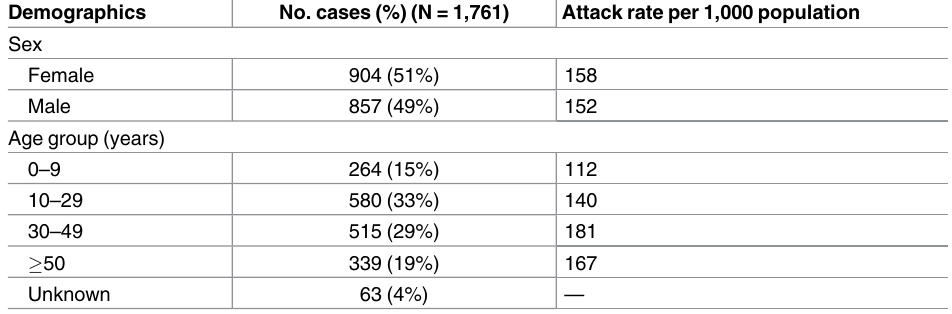
Table 1. Demographics and attack rates for clinical cases presenting to a health care facility, Yap State, August 11, 2013–August 10, 2014.